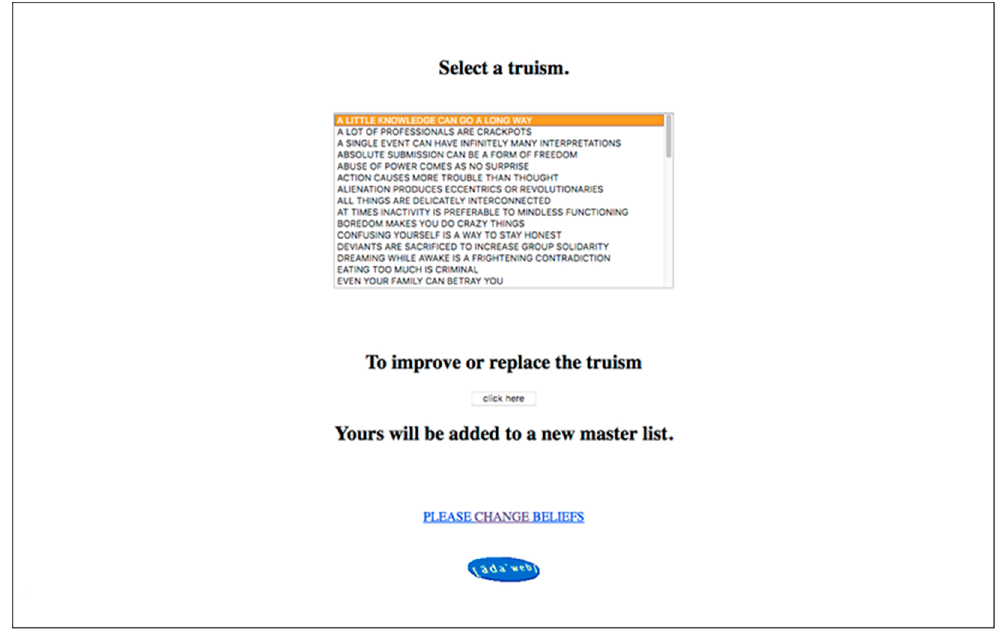
Figure 3. Jenny Holzer, Please Change Beliefs , 1995. Screenshot of the Change section, 2019. © äda’web.